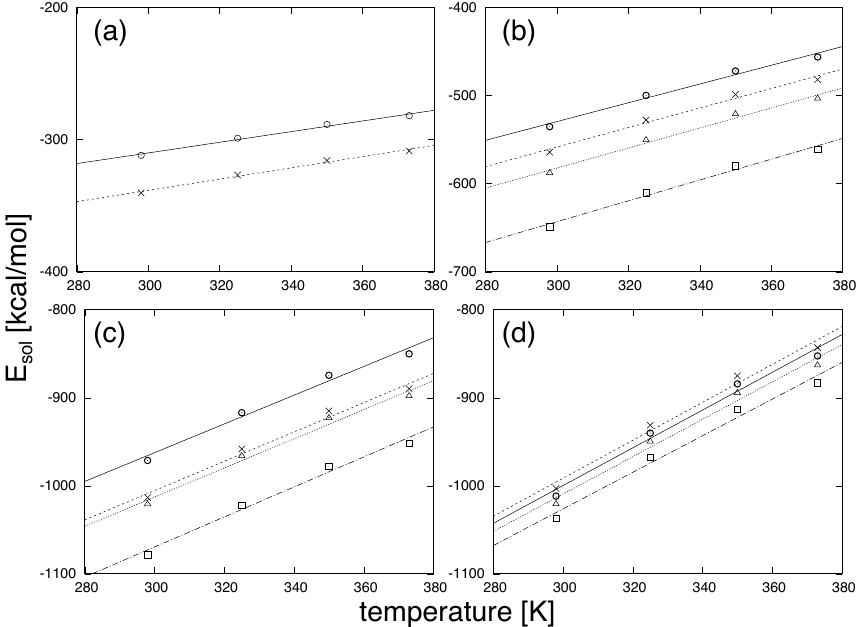
Figure 8. Solvation free energy ( E sol ) of ( a ) CLN025, ( b ) mGTT, ( c ) mNuG2, and ( d ) m α 3D as a function of temperature. Circles, triangles, crosses, and squares correspond to the end-to-end distance 10, 20, 30, and 40